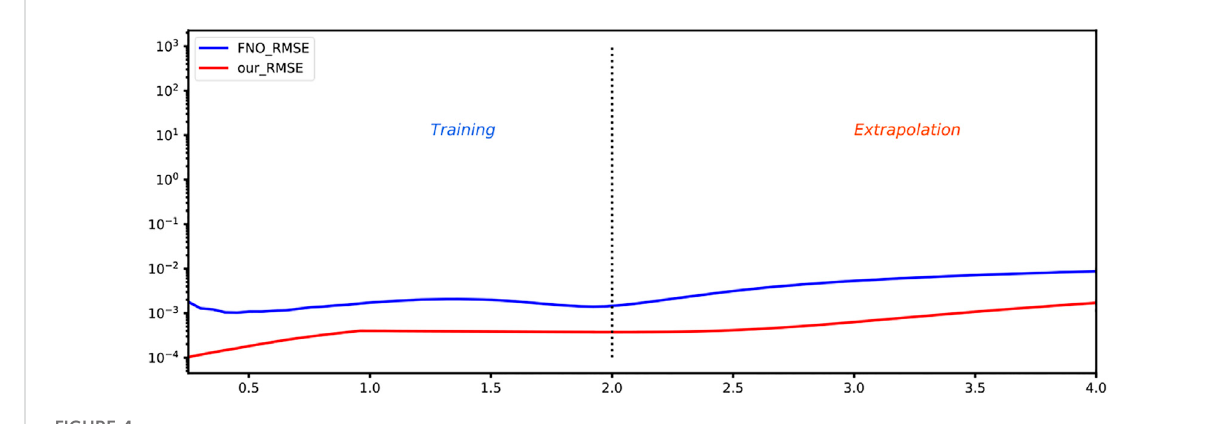
FIGURE 4 RMSE of PA_CasualLSTM and FNO for Burger ’ s equation.